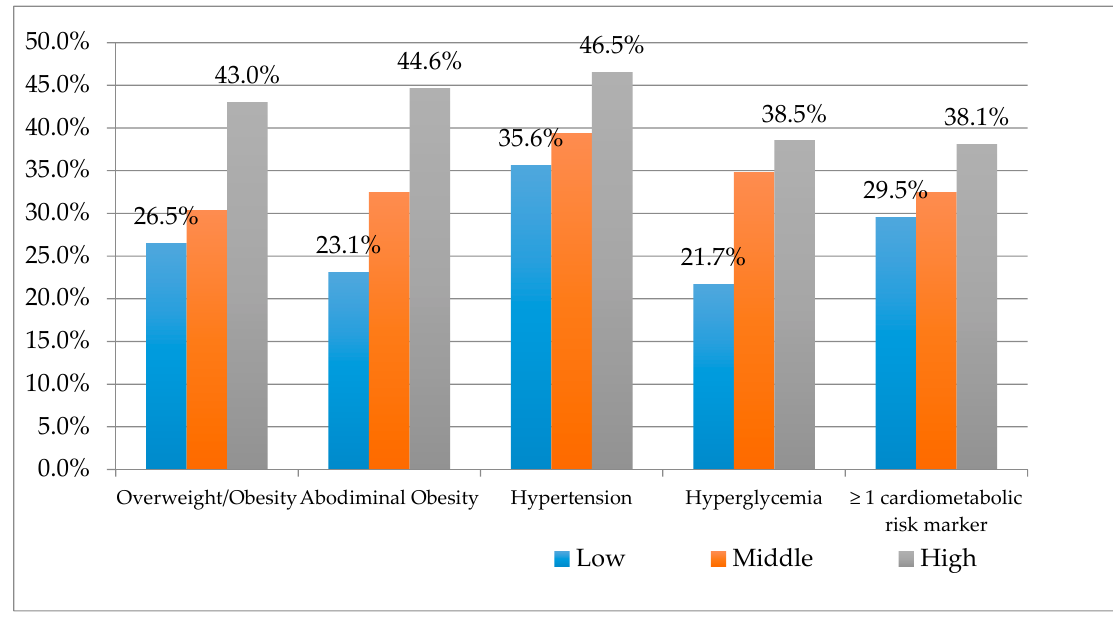
Figure 1. Cardiometabolic risk markers according to the socioeconomic status (low, middle and higher). In the figure change commas into points (ex. 5.0% into 5.0%); Abodiminal into Abdominal.